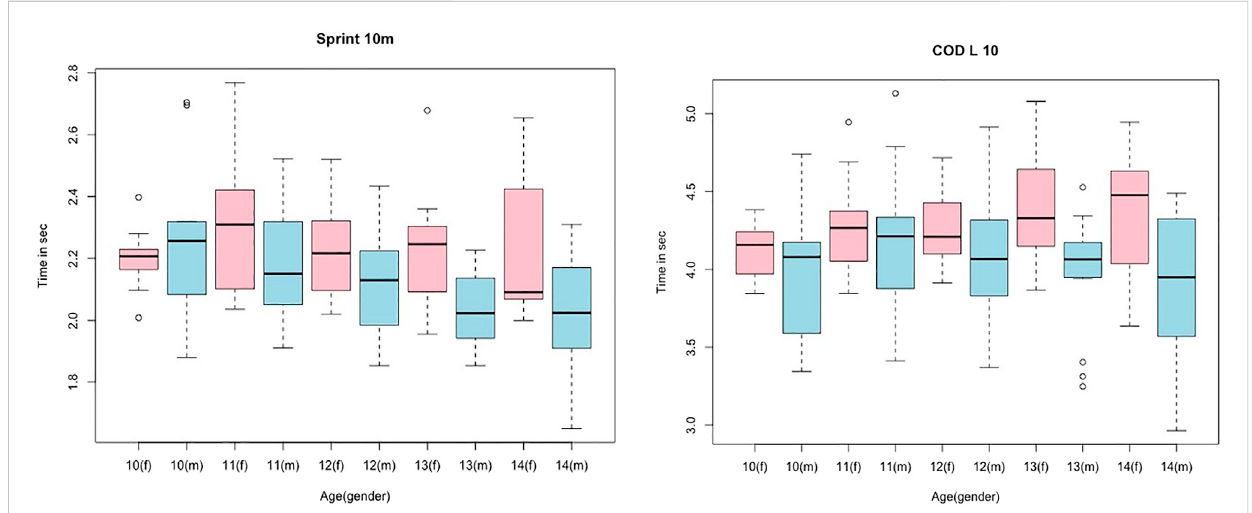
FIGURE 3 Box plots for jump height in LS10m and CODL10 dependent on age and sex; blue color represents males, and pink color represents females.